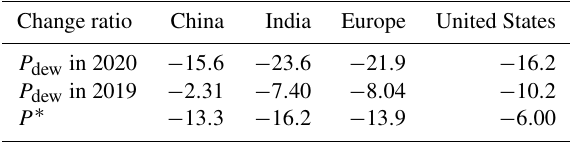
Table 1. The change ratio (%) of deweathered ( P dew ) and detrended ( P ∗ ) benzene concentrations in major regions around the